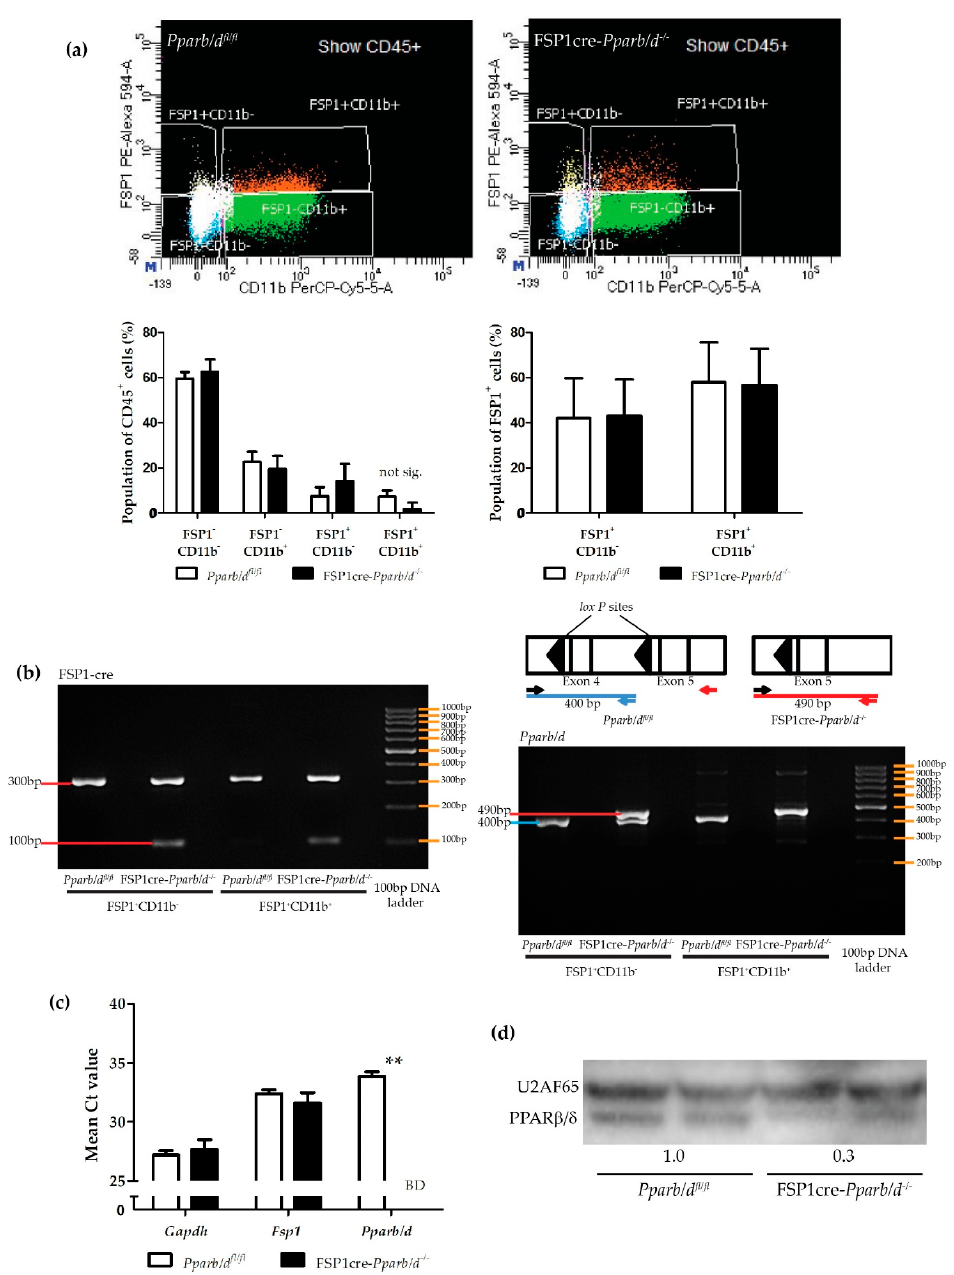
Figure 2. Distribution of FSP1 + CD11b + and FSP1 + CD11b − cells in non-parenchymal liver cells and genotyping of these isolated cells. Majority of the FSP1 + cells express CD11b. ( a ) Pparb / d fl/fl and FSP1cre- Pparb / d − / − liver FACS plots showing the CD45 + cell population, which is stained for FSP1 and CD11b, and graphs showing the distribution of cells from each quadrant in percentage (data presented as mean ± s.e.m; n = 6 biological replicates per group). Two-tailed Mann-Whitney test of the data did not find significant differences between the FSP1cre- Pparb / d − / − and Pparb / d fl/fl genotypes. ( b ) Schematic diagram showing the relative position of PCR genotyping primers for the Pparb / d lox/lox (400 bp band) and the deleted Pparb / d exon 4 alleles (490 bp band). FSP1-cre genotyping: 100